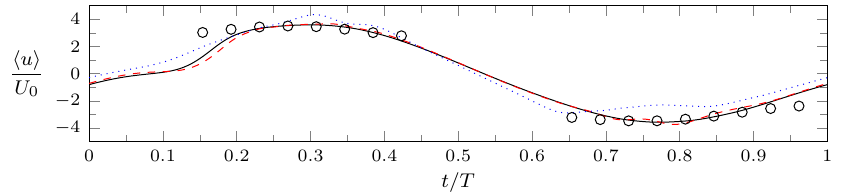
Figure 7. Comparison between experimental streamwise phase-averaged velocity measurements at the orifice exit plane (circles) and numerical results for different grid sizes: coarse (dotted line), medium (dashed), fine (solid). Validation case, s o / d = 12.5.